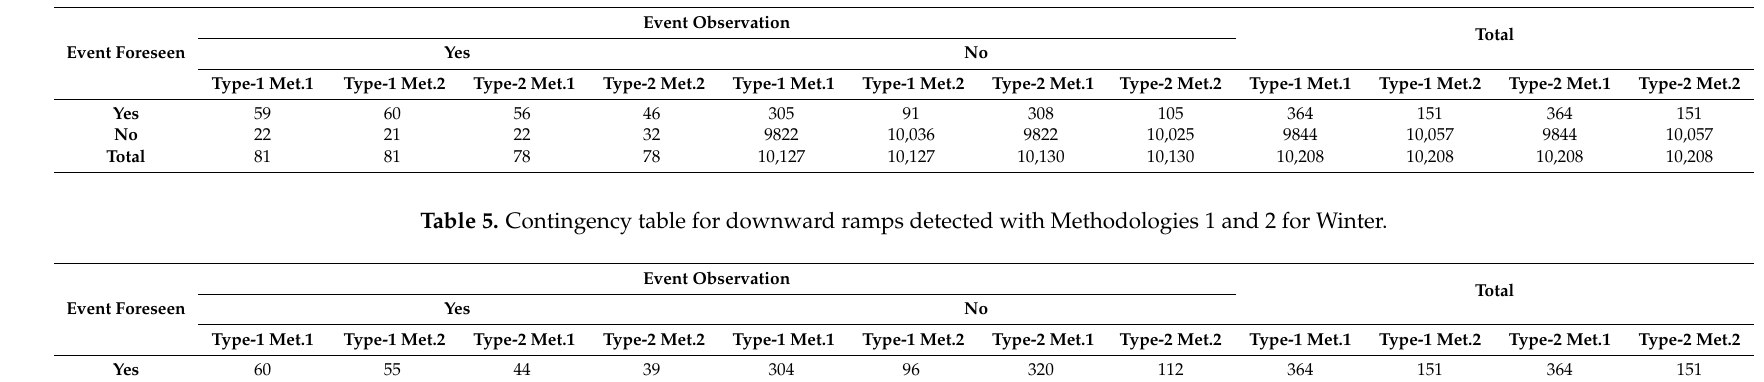
Table 4. Contingency table for upward ramps detected with Methodologies 1 and 2 for Winter.